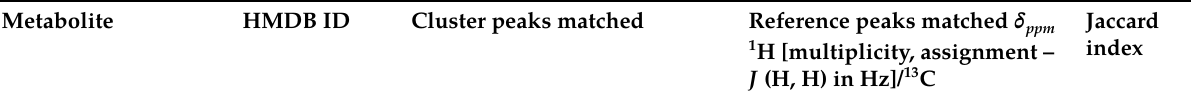
Table 3: 1 H and 13 C chemical shifts and proton multiplicity for assigned compounds found in aqueous extracts of banana peels (cv. Prata Anã) produced in southern Brazil (Santa Catarina